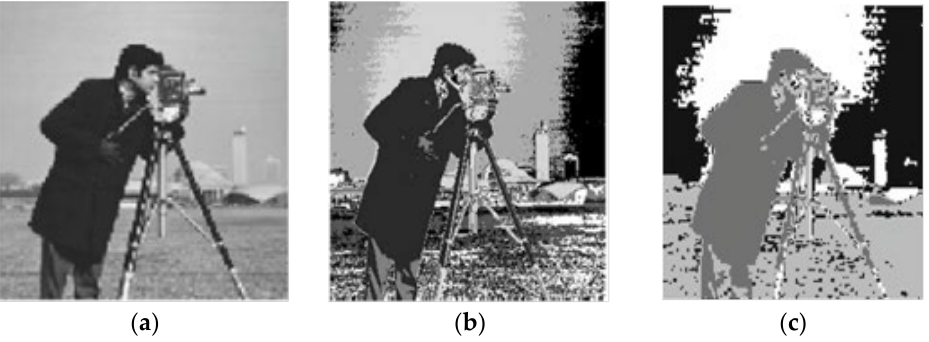
Figure 3. Cameraman segmented image: ( a ) original image, ( b ) PIABC-FCM, and ( c ) IABC-FCM.